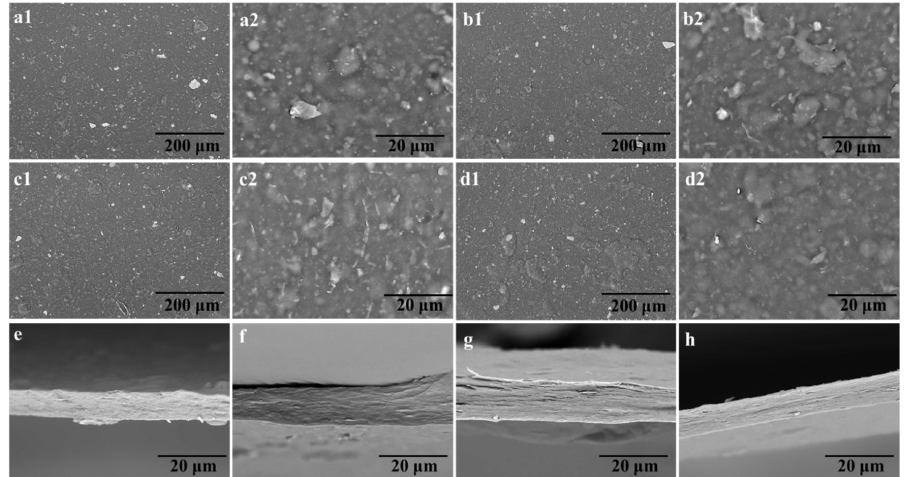
Figure 6. ( a – h ) SEM micrographs of the cellulose/PE composite films, ( a – d ) surface images of the cellulose/PE composite films with different magnification, ( e – h ) cross section images of the cellulose/PE composite films.